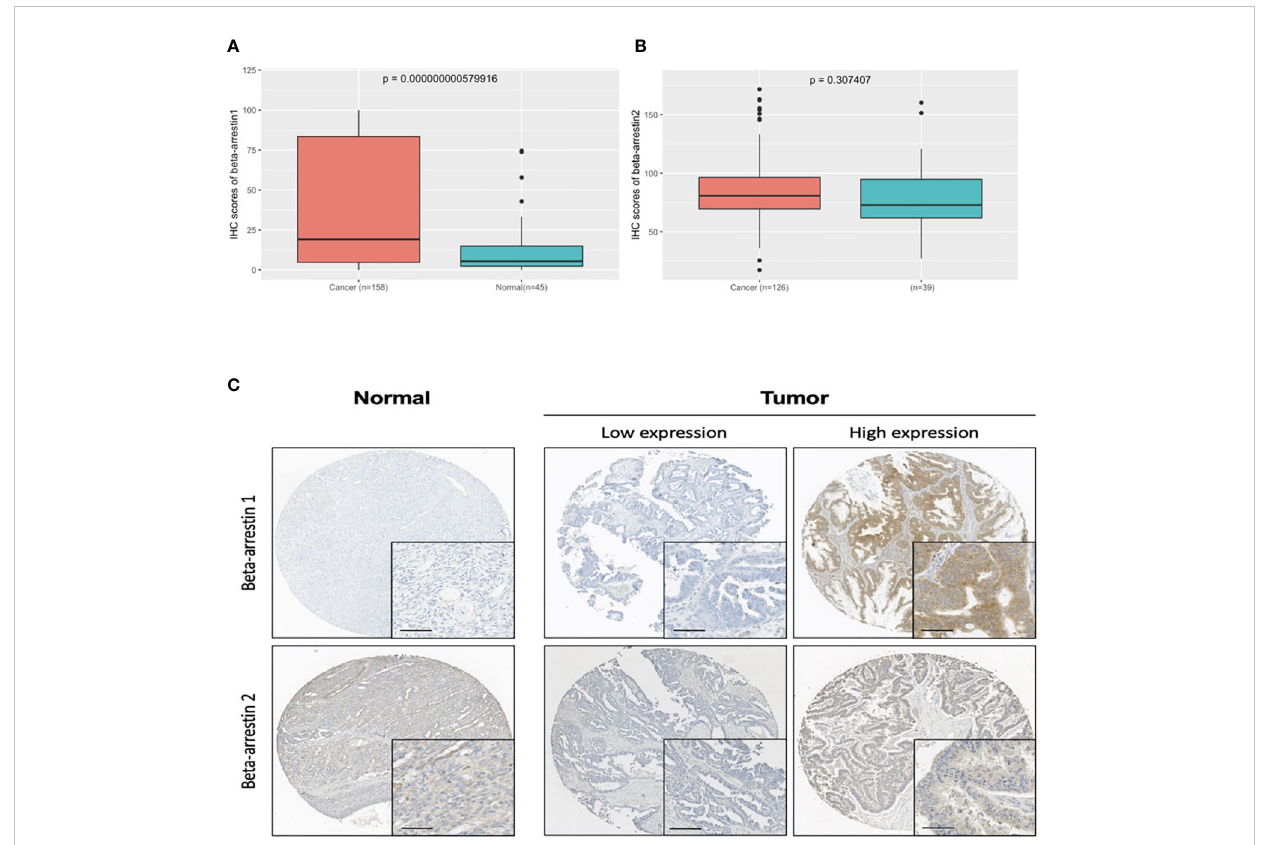
FIGURE 1 b -Arrestin expression in ovarian cancer tissues. (A) , b -Arrestin 1 expression was signi fi cantly increased in cancer tissue ( P = 5.79e − 10). (B) , b -Arrestin 2 expression in cancer tissue did not differ from that in the nonadjacent normal tissue ( P = 0.307). (C) , Immunohistochemical images of b -arrestins 1 and 2 in ovarian cancer tissues. b -Arrestins 1 and 2 were detected in the cytoplasm. (scale bar: 50 m